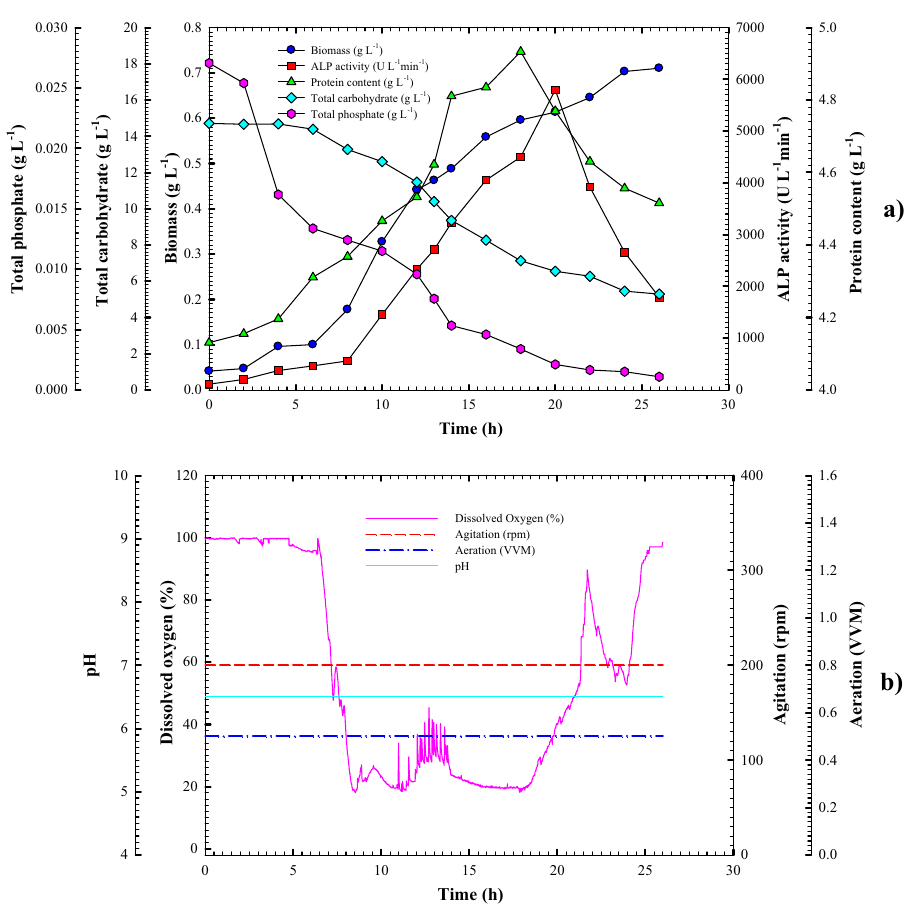
Figure 7. (a) Monitoring of Lysinibacillus sp. strain APSO growth and ALP productivity in a 7 L stirred-tank bioreactor under controlled pH conditions. (b) Online data (DO, agitation, airflow rate, and pH) as a function of time during said batch